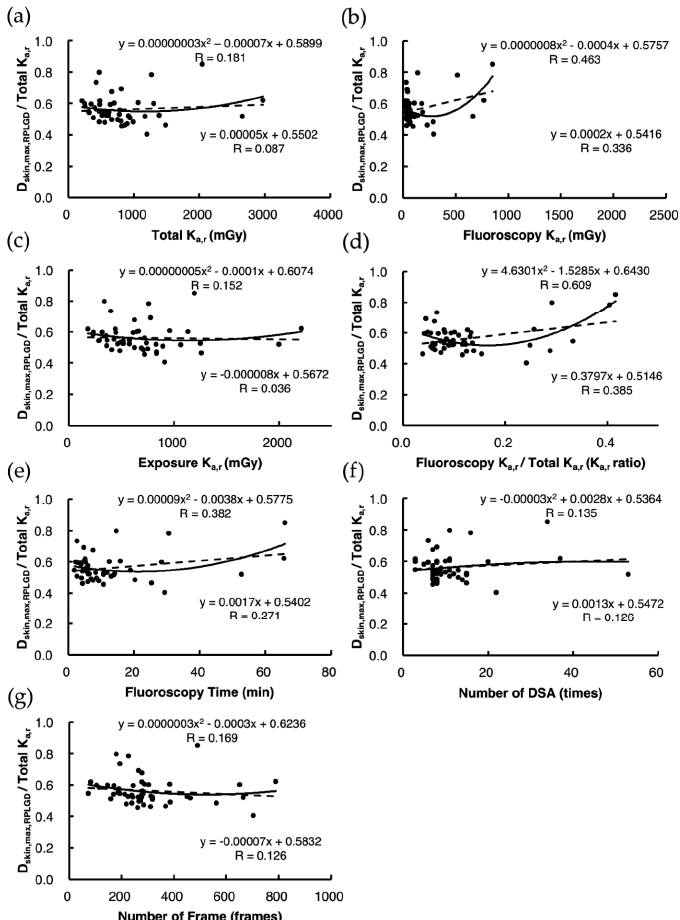
Figure 4. Analysis of the factors affecting D skin,max,RPLGD /Total K a,r using the validation data set ( n = 50). The broken lines indicate linear regression, and the solid lines indicate quadratic regression. We analyzed the correlations between D skin,max,RPLGD /Total K a,r and the following Digital Imaging and Communication in Medicine—Radiation Dose Structured Report parameters: ( a ) Total K a,r ; ( b ) Fluoroscopy K a,r ; ( c ) Exposure K a,r ; (d) Fluoroscopy K a,r /Total K a,r (K a,r ratio); (e) Fluor- oscopy Time; ( f ) Number of DSA; and ( g ) Number of frames.